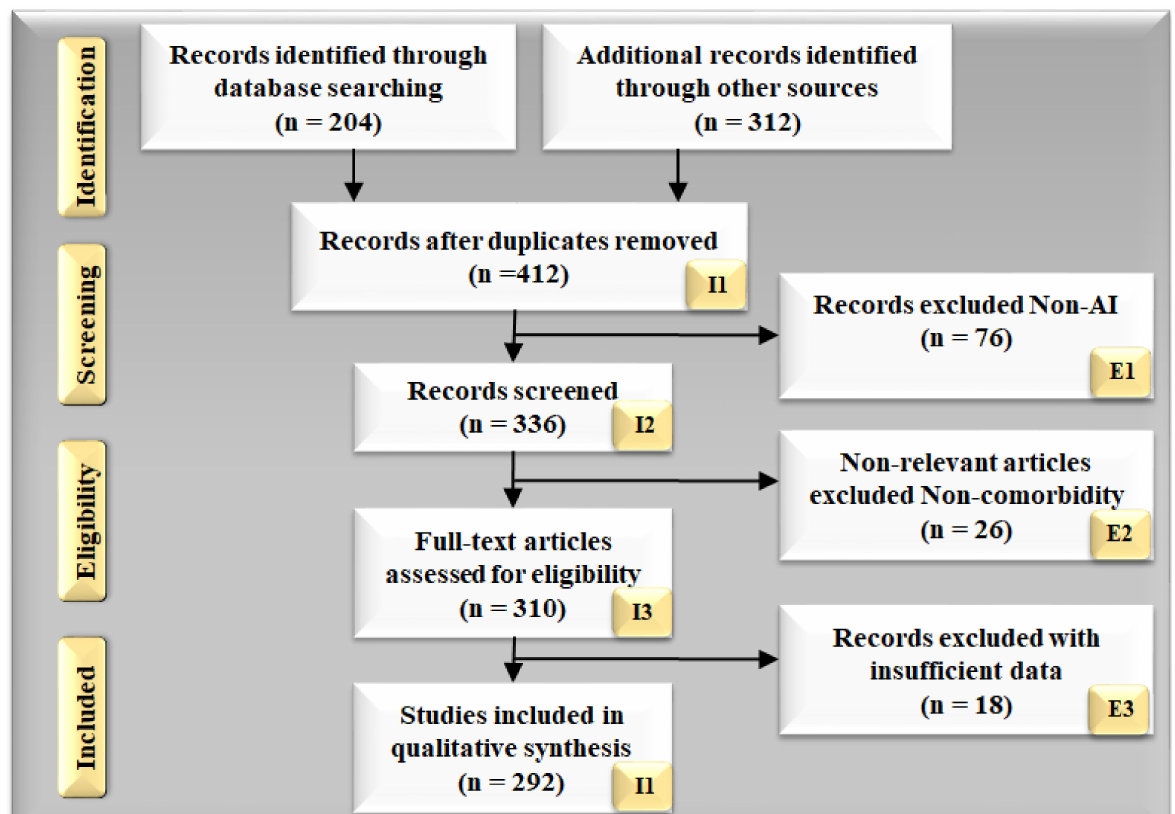
Figure 1. PRISMA model for selection of the studies, dealing with the effect of COVID-19 on PD for CVD and stroke risk stratification. (I: Included, E: